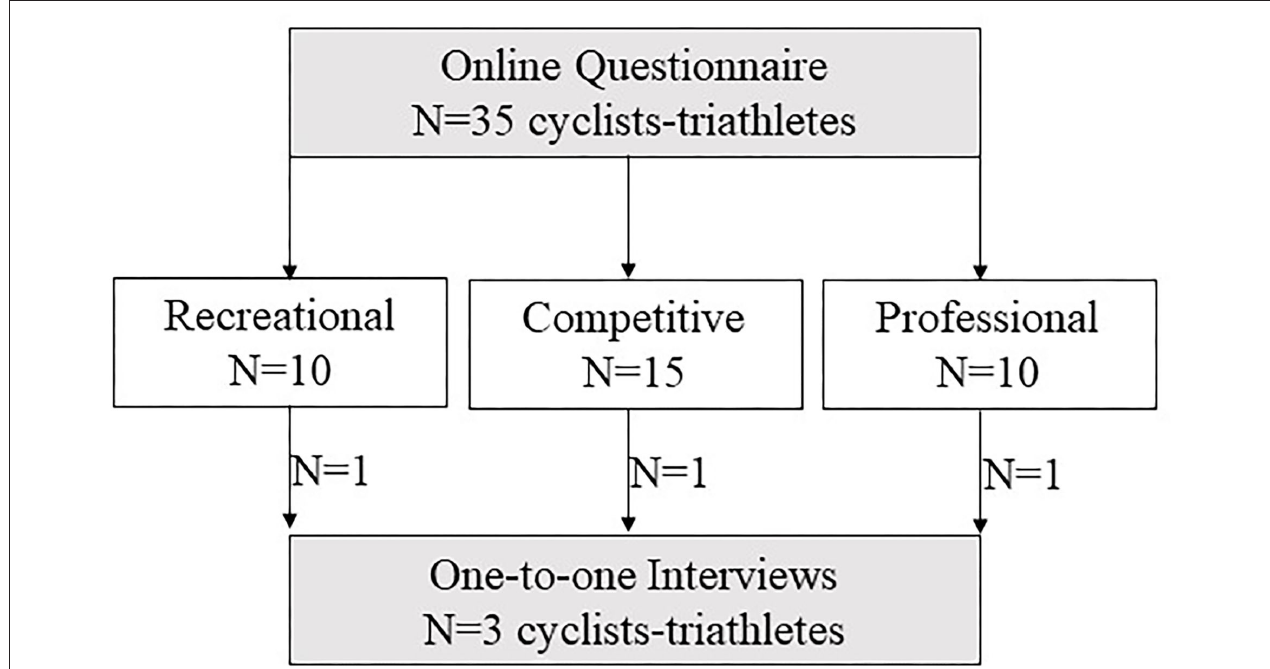
FIGURE 1 | Methodological flow chart of the study design. Grey boxes, data collection; white boxes, participants.